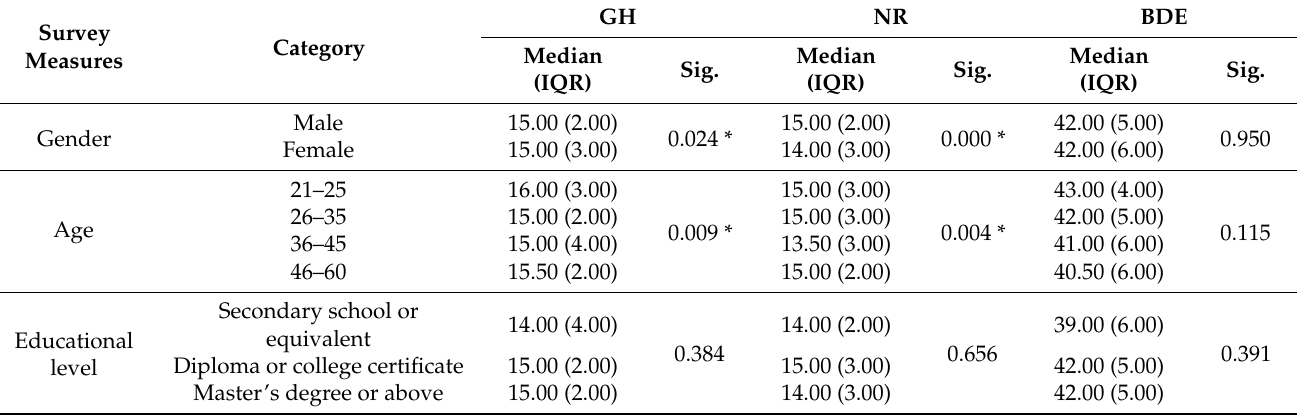
Table 9. Comparison of independent variables (Gender, Age, Educational Levels, Weekly Working Hours, Daily Sedentary Time, Work Desk Locations, Working Years, Office Locations) on self-reported GH, NR, and